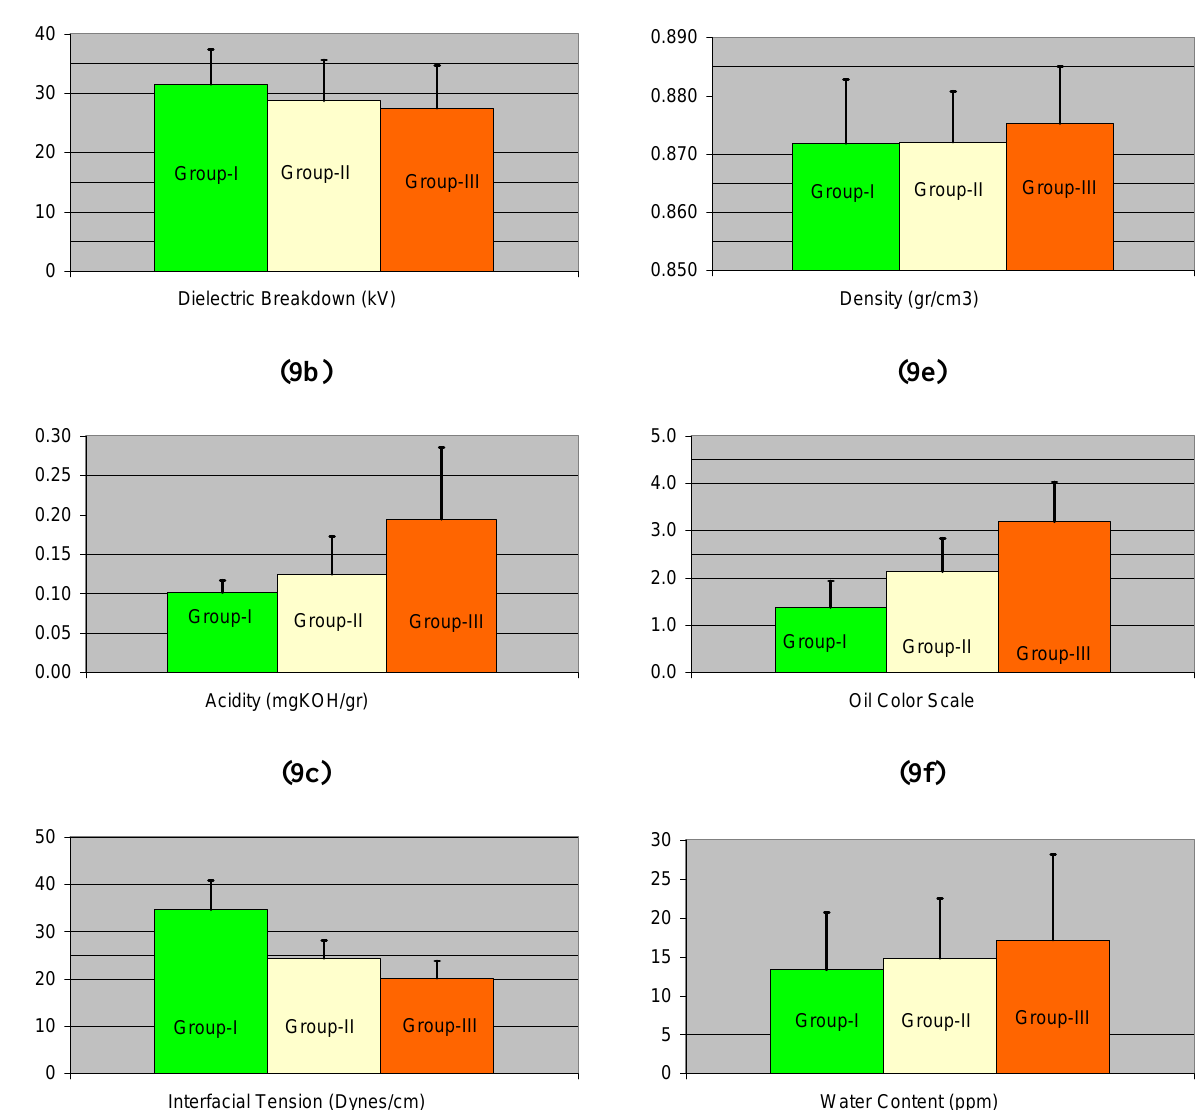
Figure 9. Cumulative average values of measured physicochemical quantities with range of standard deviations (plus) for the examined oil samples within various groups (Group-I, Group-II, Group-III). Group characterization based upon oil permittivity